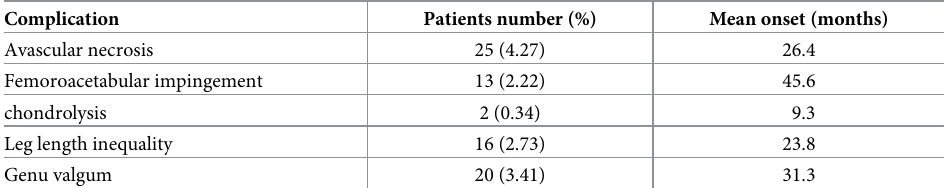
Table 2. Complications after SCFE